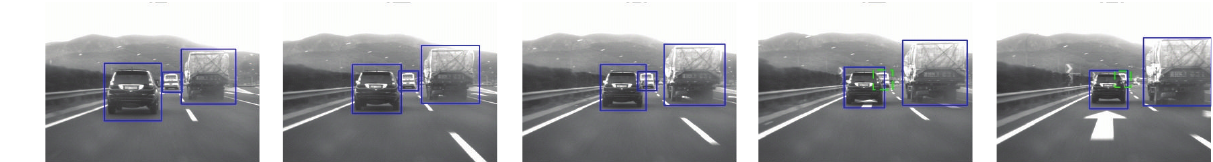
Figure 7: Vehicle filtering with temporal